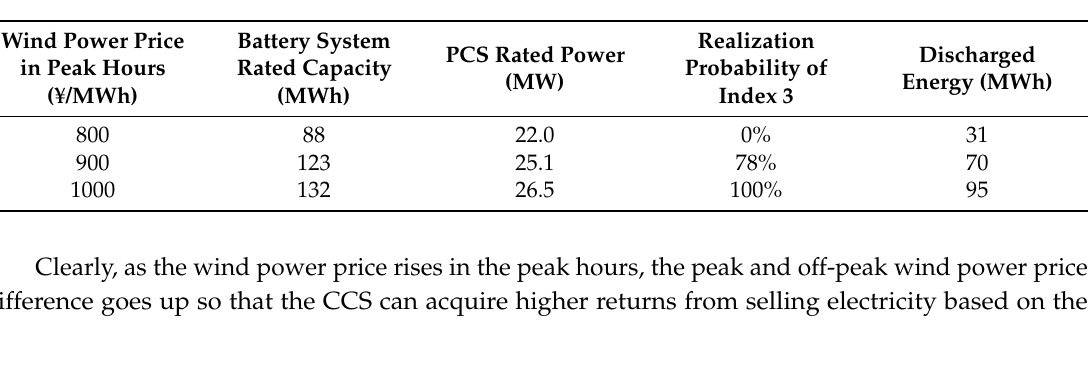
Table 5. Effect of peak and valley difference of wind power price on optimization